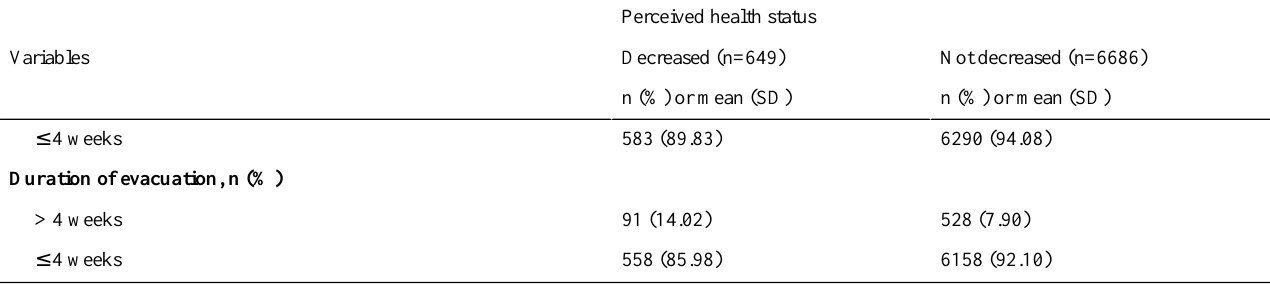
a Change of categorical level, where a unit of “level” represented approximately one million yen. Example: difference is −2 when the level was 5 in 2010 and 3 in